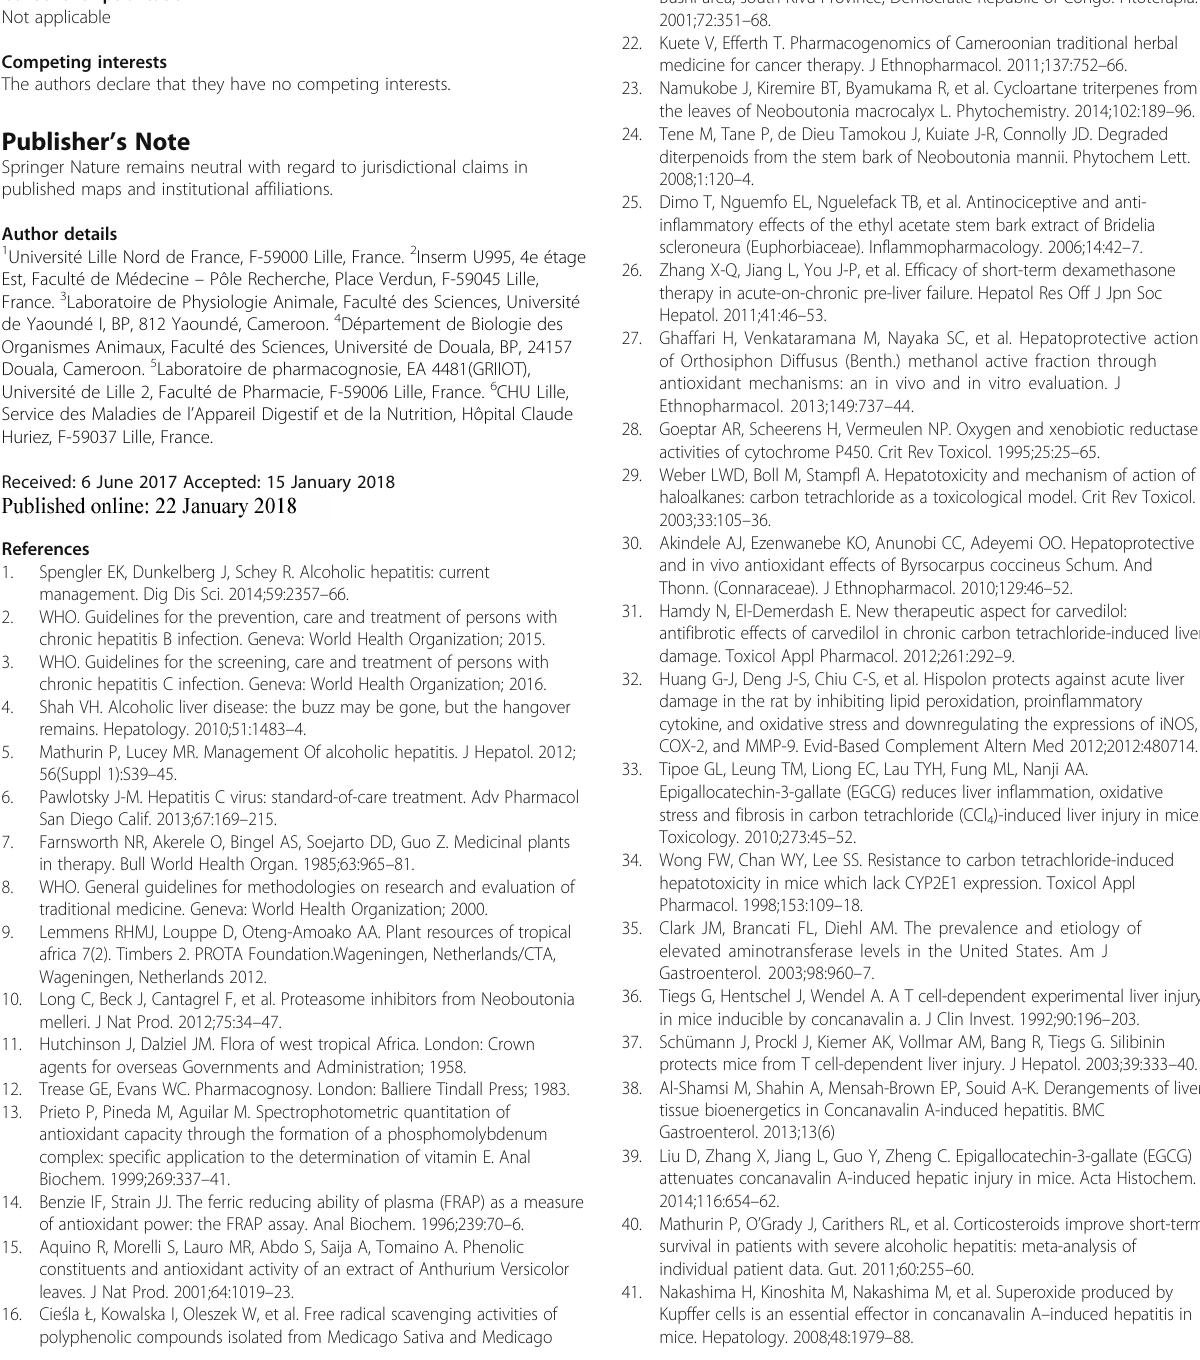
Figure S3 and Additional file 4: File S4). Further information is available from the corresponding author upon reasonable request. Ethics approval and consent to participate Animal experiments were performed in accredited facilities (n° A59 – 35015) according to European governmental guidelines (n°2010/63/UE) and French national law ( “ Décret ” n° 2013 – 118). The protocol received approval from both the local ethics committee of the University of Lille (France): “ Comité d ’ Ethique en Expérimentation Animale Nord-Pas-de-Calais ” (CEEA 75) and the French Ministry of Post-Graduate Education and Research